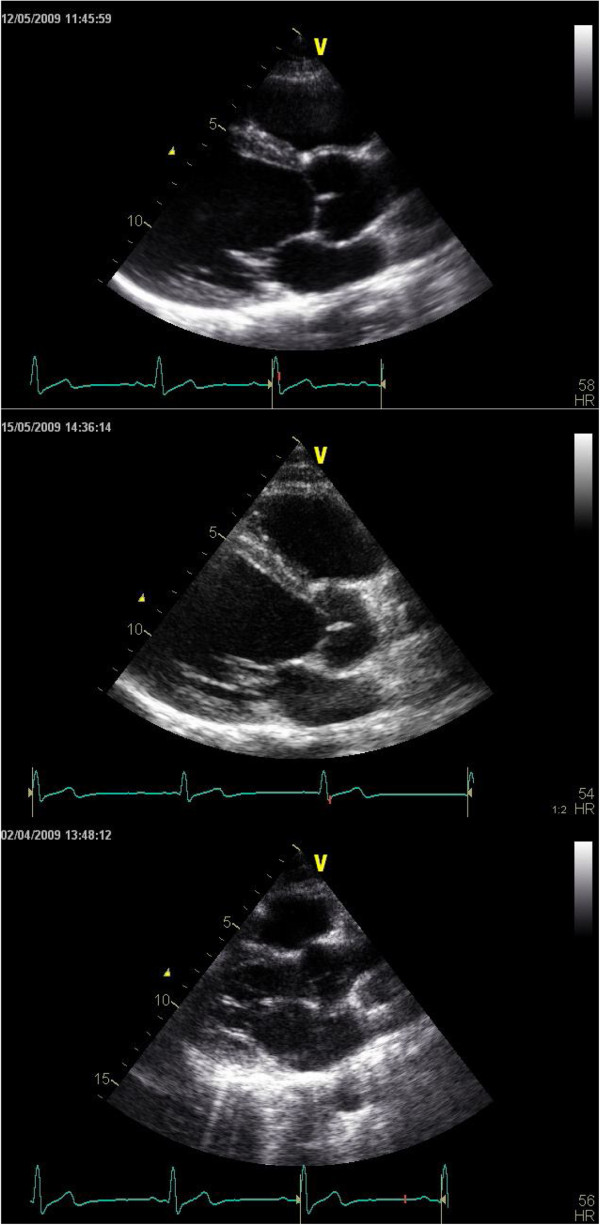
Grading the 2D parasternal long axis (PLAX) view. The grading includes anatomical presentation, use of screen and use of technical settings. This figure shows a PLAX image from an expert (top) an intermediate (middle) and a novice (bottom). The blinded scores for the anatomical presentation was expert 5 (very good), intermediate 3(adequate) and novice 1(very poor), for use of screen 5 (very good), 4(good) and 2(poor), and for use of technical settings 4(good), 4(good) and 3(adequate). All scores were finally added up to a total checklist score.